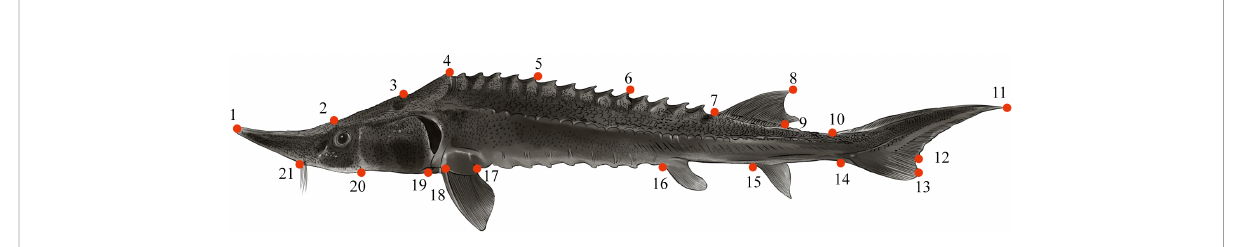
FIGURE 4 The 21 landmarks used for examination of lateral body shape (boldness depicted). 1. Snout tip; 2. Upper snout end; 3. Upper head end; 4. Dorsal origin; 5-6. Dorsal rhomboid primitive spikes; 7. Origin of dorsal fi n base; 8. Highest point of dorsal fi n; 9. Base end of dorsal fi n; 10. Dorsal origin of caudal fi n; 11. Upper lobe terminal of caudal fi n; 12. Deepest part of the caudal fi n; 13. Lower lobe terminal caudal fi n; 14. Ventral origin of caudal fi n; 15. Origin of anal fi n; 16. Origin of pelvic fi n; 17. End of pectoral fi n; 18. Origin of pectoral fi n; 19. Lower head end; 20. Base of operculum; 21. Lower snout